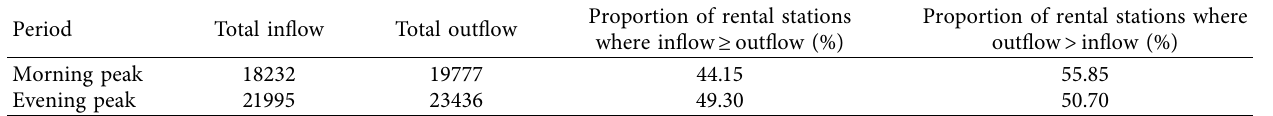
Figure 2: Daily variation tendency of bicycle-sharing travel demand in (a) different time periods and (b) different administrative districts. Table 4: Statistical analysis of rental stations’ inflow and outflow during rush